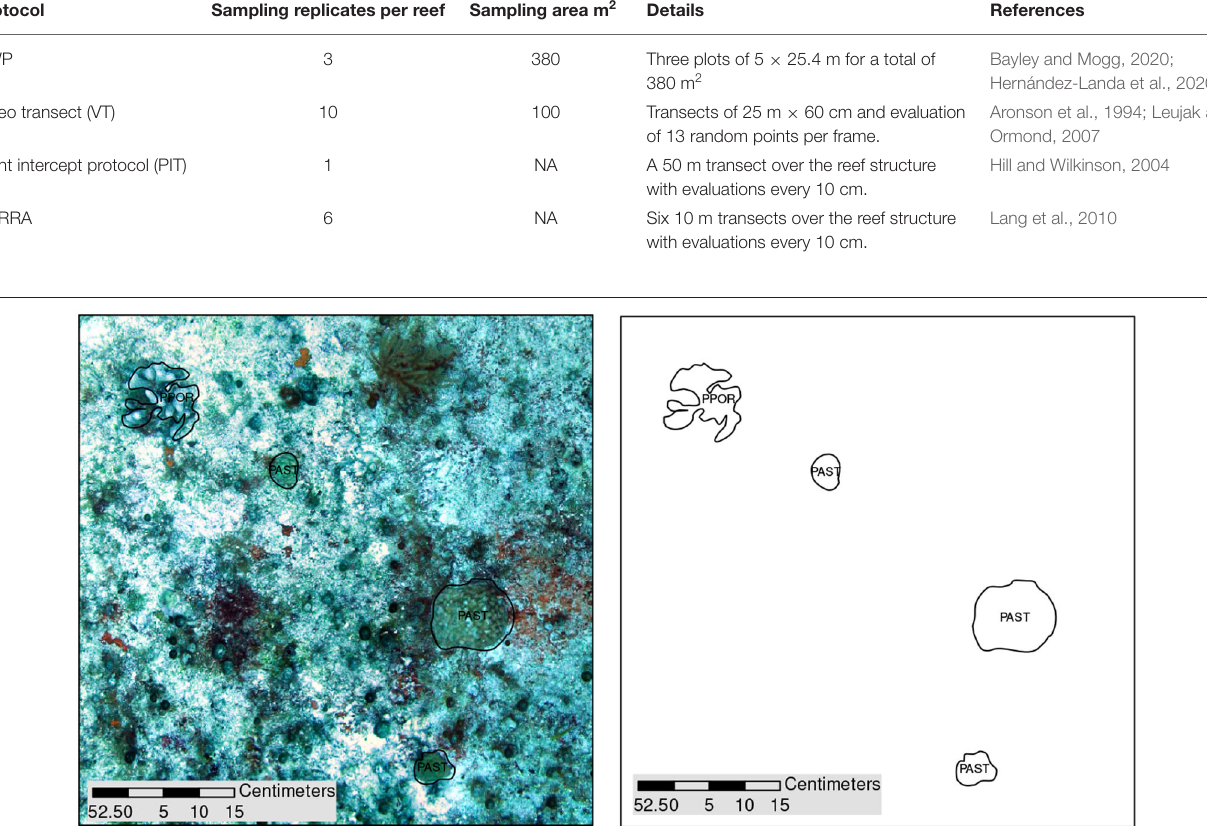
FIGURE 2 | Stony corals from a high-resolution (1.3 mm/pixel) orthomosaic (left) . The boundaries of each coral colony (right) were digitized and identified ( Porites porites , PPOR; Porites astreoides , PAST), The benthic cover was estimated with the spatial information in each vector on the software Arcmap v.10.5. The code used is in accordance with the AGRRA protocol (see